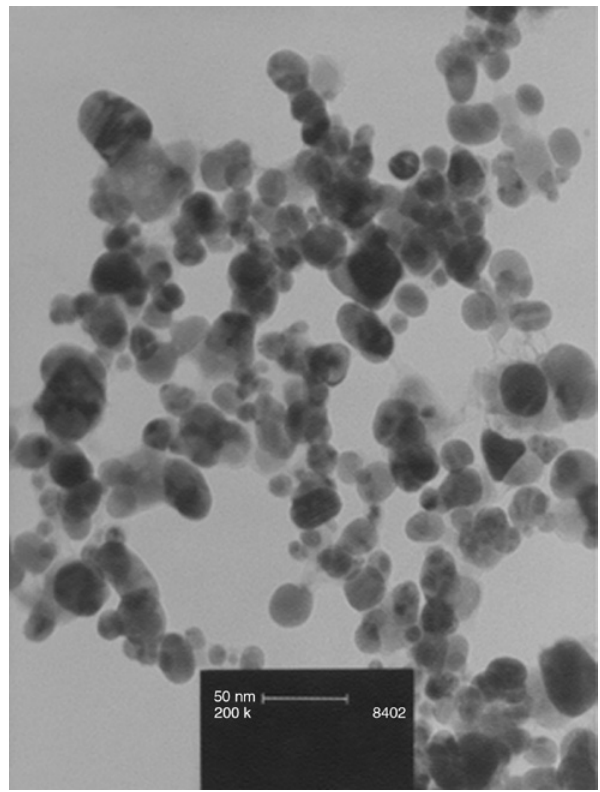
Figure 7: TEM image of the synthesized AgNPs at obtained optimum synthesis conditions using Aloe vera